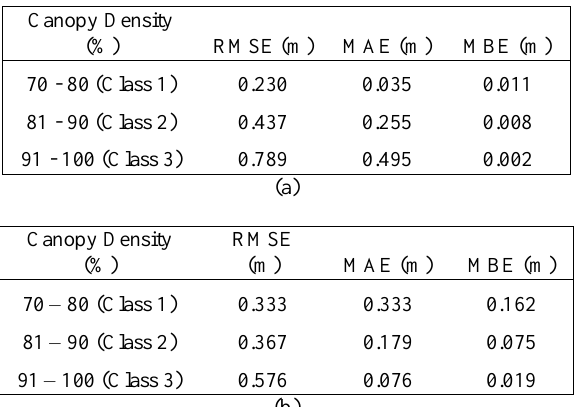
Table 4. Error of LiDAR-derived DTM associated with canopy cover over (a) rubber trees area, and (b) mixed-forest area